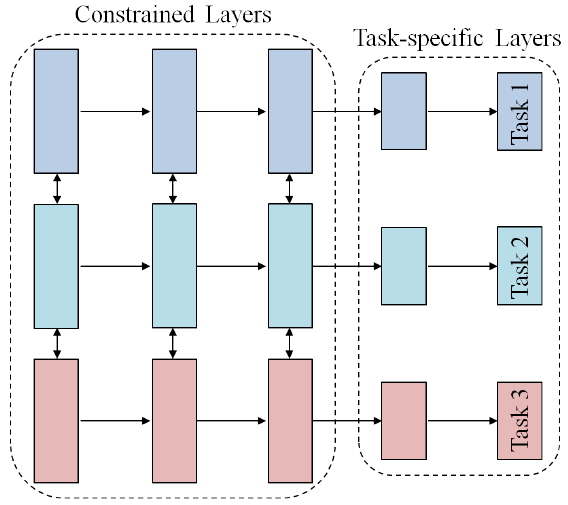
Figure 4. Soft parameter sharing in multi-task